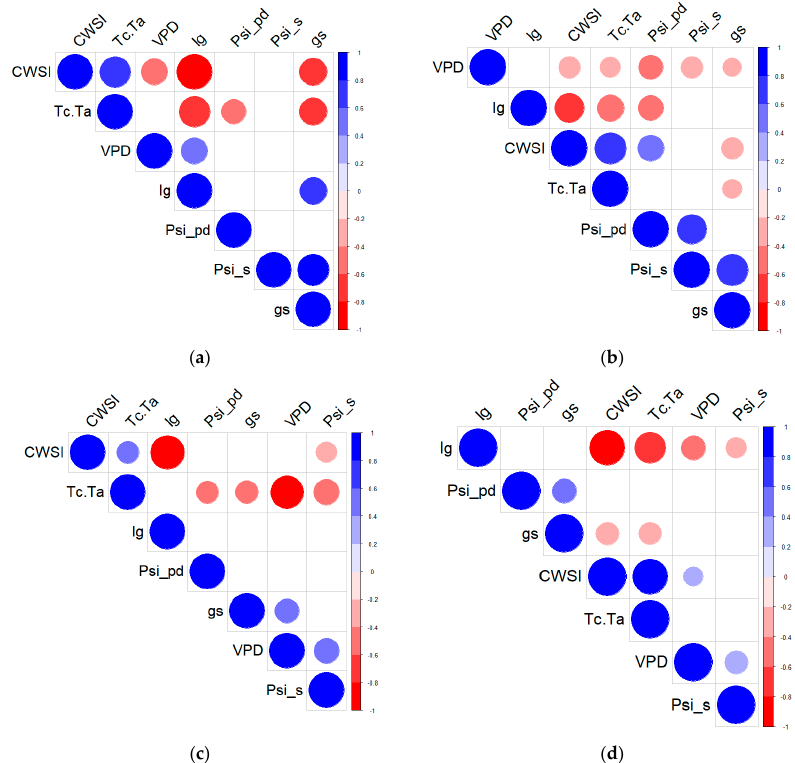
Figure 5. Correlation map (correlogram) of remotely-sensed thermal indices (CWSI, I g , (T c -T a )) along with environmental conditions (VPD) and vine water status (g s , Psi_s or Ψ s ) for two cultivars and timepoints for the 2017 (S2) growing season: SHI veraison ( a ), CAS veraison ( b ), SHI pre-harvest ( c ) and CAS pre-harvest ( d ). Only significant Pearson correlation coefficients ( p ≤ 0.05) are shown. Blue circles correspond to significant positive correlations and red circles to significant negative correlations. The size of the circle reflects the magnitude of the Pearson correlation coefficient.